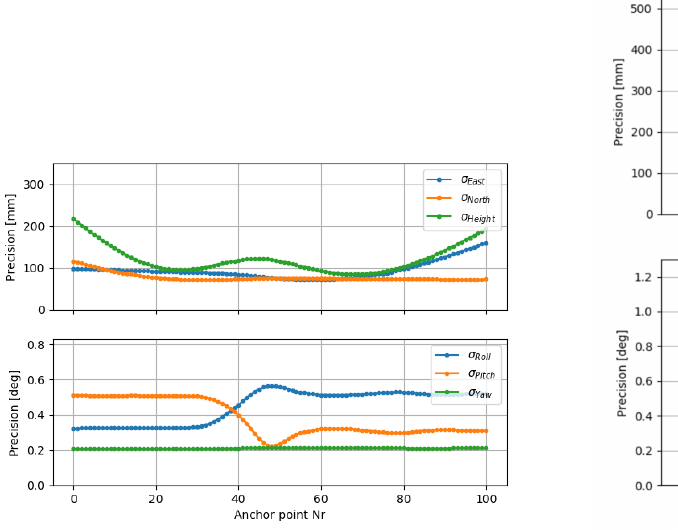
Figure 13. Results of platform back , scenario 5 (details see figure